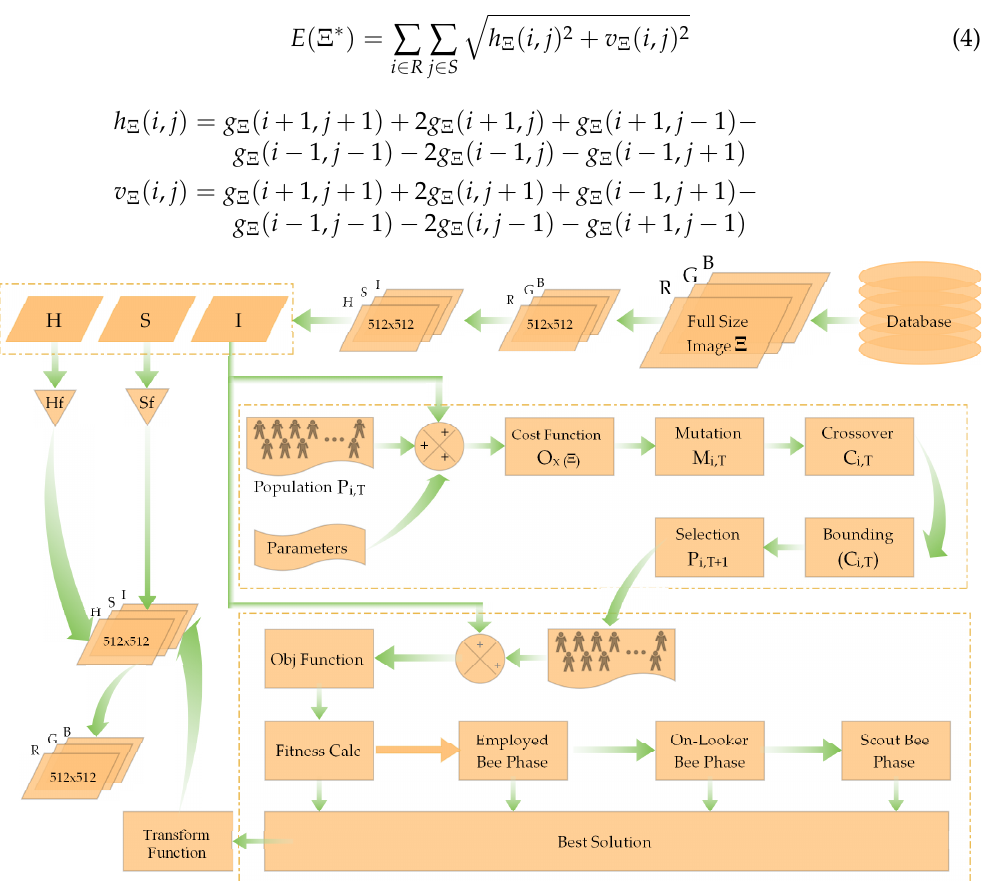
Figure 4. Block diagram of proposed